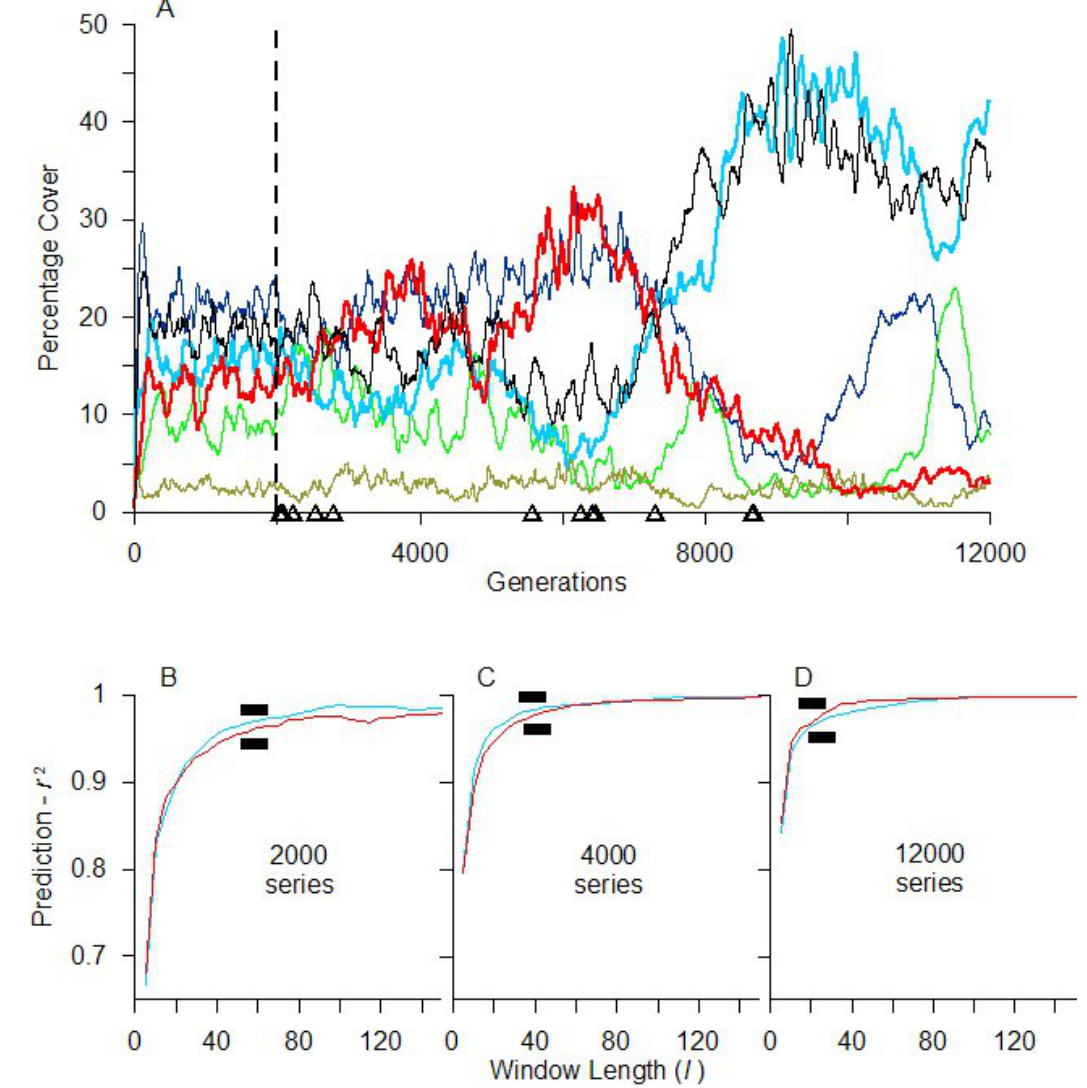
Fig. 5. Effects of a shifting attractor on the CLS of a 20-species system. (A) Temporal dynamics of six of the 20 species. Up to generation 2000, all 20 species coexist and community structure is approximately constant because “open” recruitment enables recruits of all species to establish (with equal likelihood) on small patches on the landscape cleared by a low level of disturbance (see Methods). At generation 2001, the “open”recruitment is “turned off” and species begin to go locally extinct (extinction points are indicated by triangles on the x-axis), which leads to different landscape dynamics. Prediction-r 2 spectra are shown for analyses based on series of five maps finishing at generation 2000, 4000, and 12 000 (B–D, respectively), where consecutive maps in each series were separated by 10 time steps. Spectra are based on analysis of densities of two species (S and S , shown as bold lines in A). red blue Both species indicate a reduction in the CLS from about 55 length units to about 20 length units. Areas identifying the CLS are shown as black horizontal